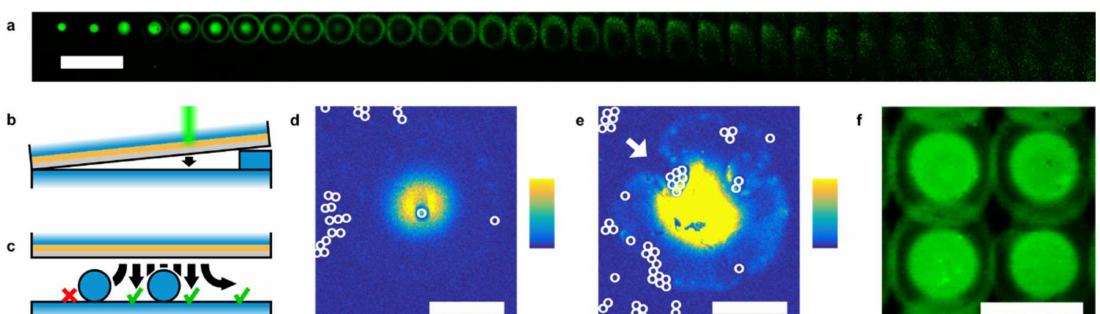
Figure 2. ( a ) Fluorescent image of deposition patterns with increasing distance (shown here up to 580 µ m) between the donor and acceptor slides (a sketch of the experiment is shown in ( b )): A ring occurred around the spot while its core was vanishing. For large distances (right end of the fluorescence image), the ring drifted away from the irradiated location. The scale bar represents 1 mm. ( c ) Scheme of an experiment to determine the flow direction in the gap: obstacles, here micro-spheres (diameter 10 µ m), could block the lateral flow. ( d , e ) Fluorescent images of the deposition pattern blocked by micro-spheres (individual pseudo-colors for increased contrast; scale bar 100 µ m). ( f ) Fluorescent image of overlapping patterns. The length of the scale bar is 250 µ